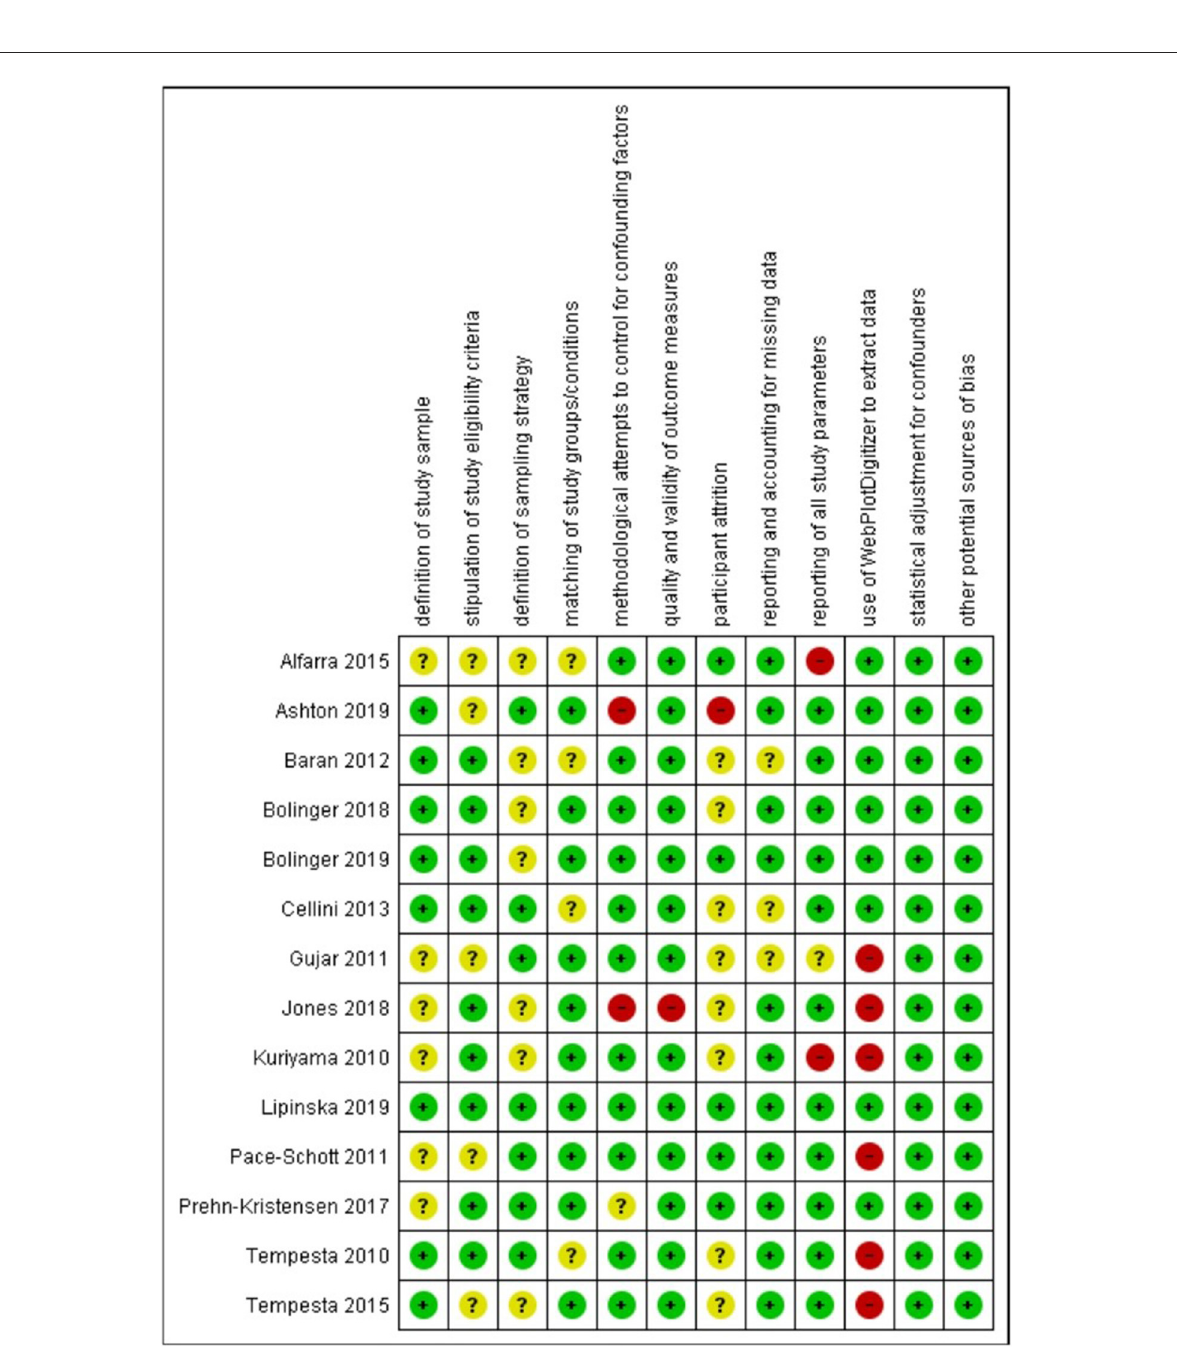
FIGURE2 Risk of bias (low, unclear, or high) for each study included in meta-analysis on each rated methodological dimension ( N =